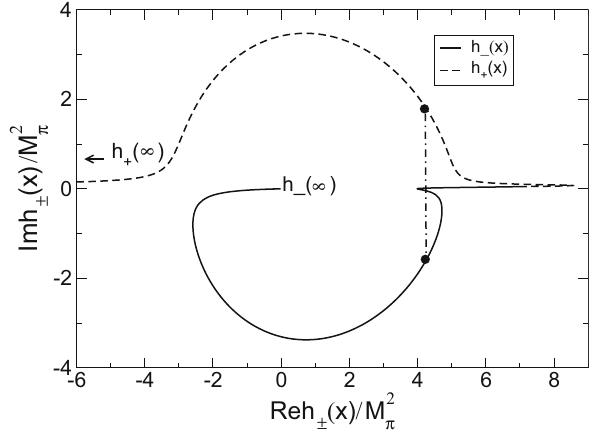
Fig. 2 Real and imaginary parts of the endpoints h ± ( x ) in (7) in the angular averages (4), for x ∈ [ 4 M 2 π , ∞ ) . For better visibility, we have kept in the eta mass a positive imaginary part. Solid (dashed) line: lower (upper) endpoint. The dash–dotted line connects h − ( x ) with h + ( x ) , with x 2 < x < x 3 . It is seen that this line crosses the original path of integration in the dispersive representation (2). The same happens for x 1 < x < x 2 . See text for details